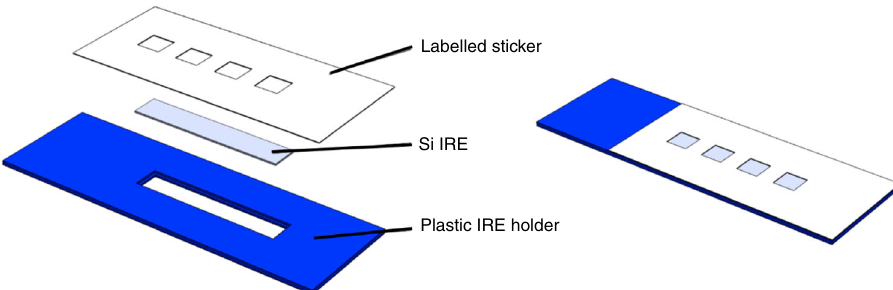
Fig. 2 Expanded view of optical sample slides. Silicon internal re fl ection elements (Si IREs) are sandwiched between a 3D printed plastic holder and a medical grade labelled sticker. The latter de fi nes the optically active regions of the Si IRE, split into four wells, three used for triplicate sample analysis and